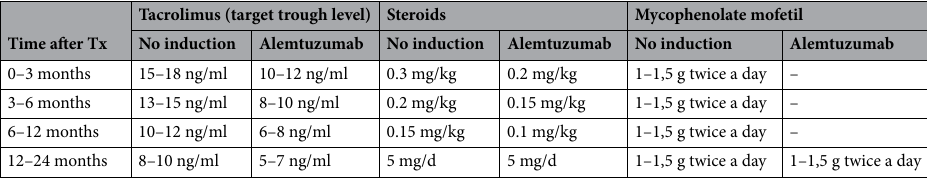
Table 4. Maintenance immunosuppression